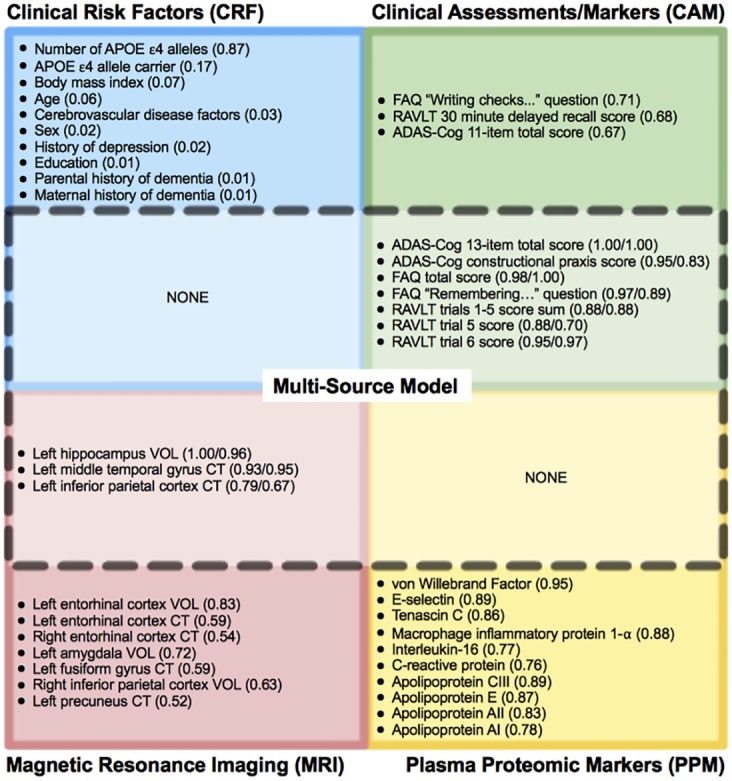
Top 10 most frequently selected features as baseline predictors of MCI-to-dementia progression.Features are shown separately for each single-source model: CRF (blue), CAM (green), MRI (red), PPM (yellow). A subset of these features (dashed line) was selected as part of both the single-kernel (CONCAT) and the multiple-kernel (MKL-Gaussian) multi-source models and included only CAM and MRI features. The selection frequency across 100 trials of the 10x10 cross-validation experiment is shown in parentheses as: (#) for single-source model only or (#/#) for both single/multi-source (MKL-Gaussian) models. APOE = apolipoprotein E, ADAS-Cog = Alzheimer's Disease Assessment Scale–Cognitive sub-scale, FAQ = Functional Activities Questionnaire, RAVLT = Rey Auditory Verbal Learning Test, VOL = volume, CT = cortical thickness.